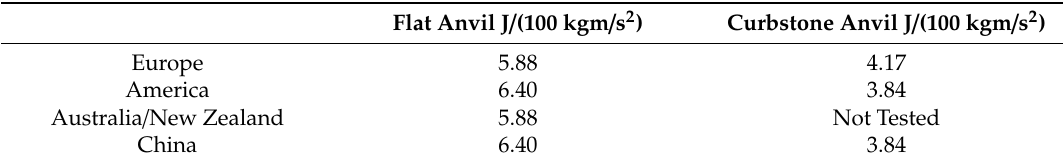
Table 2. Minimum energy absorbed for same head form and helmet